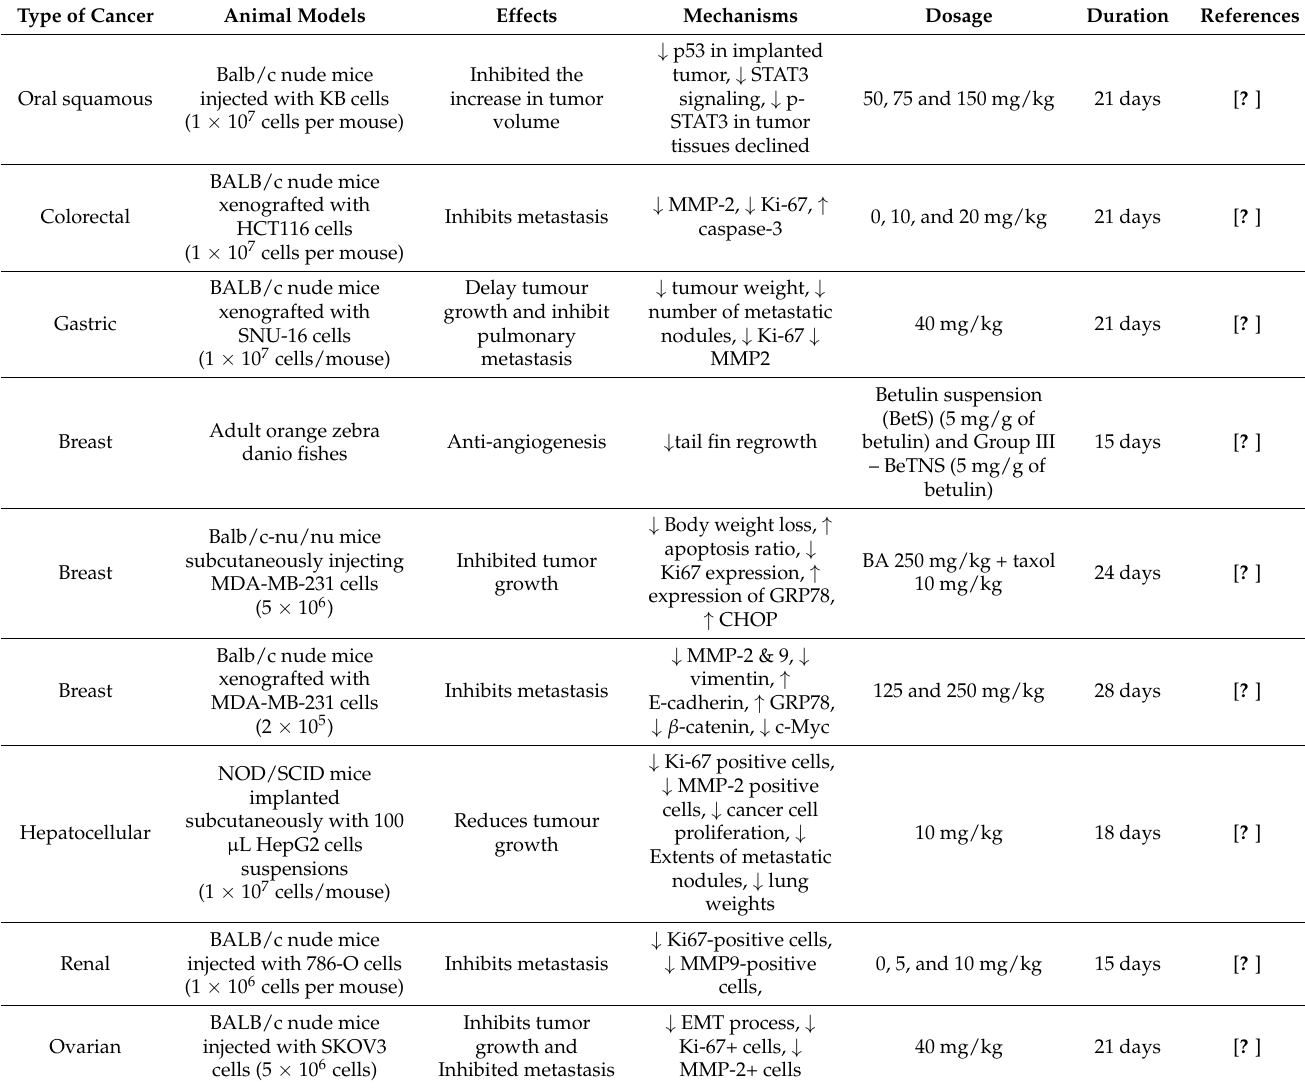
Table 2. Anticancer effects of betulin and betulinic acid based on in vivo